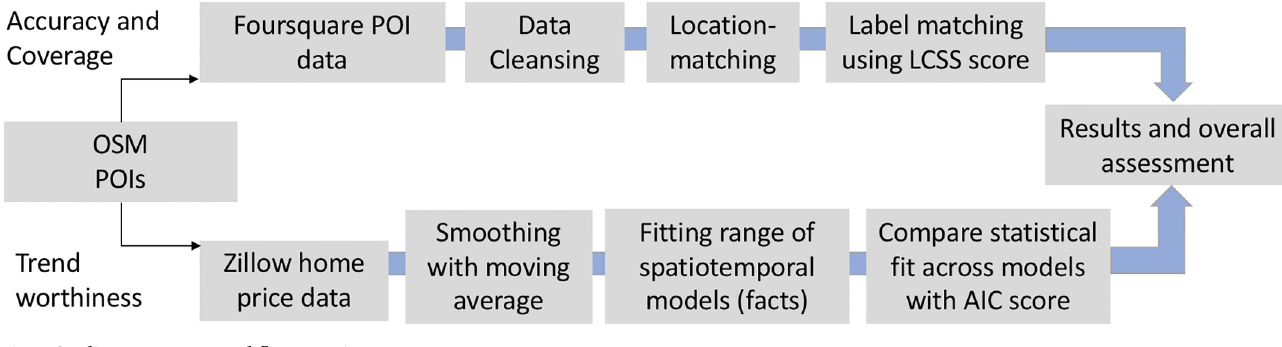
Fig 9. Quality assessment workflow